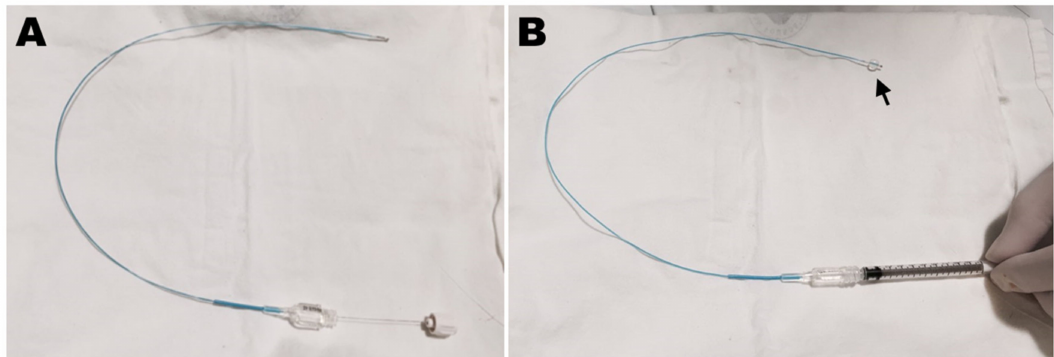
Figure 1. The novel inflatable balloon catheter used in the transforaminal approach (ZiNeuF ® ). ( A ) This 2-Fr inflatable balloon catheter is thinner than other catheters but is more maneuverable because of the guidewire. ( B ) The inflatable balloon is positioned on the tip of the catheter (arrow). After the air in the catheter is removed, the catheter is connected to a 1 mL Luer-Lock syringe containing 0.13 mL of contrast medium for